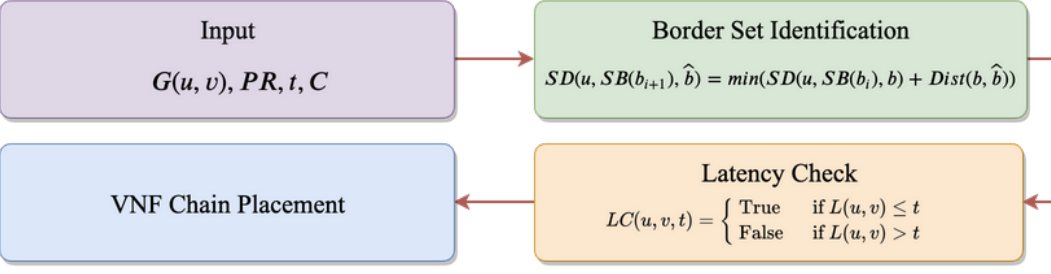
Figure 5. The flowchart of the BVCP algorithm. Algorithm 1: BVCP